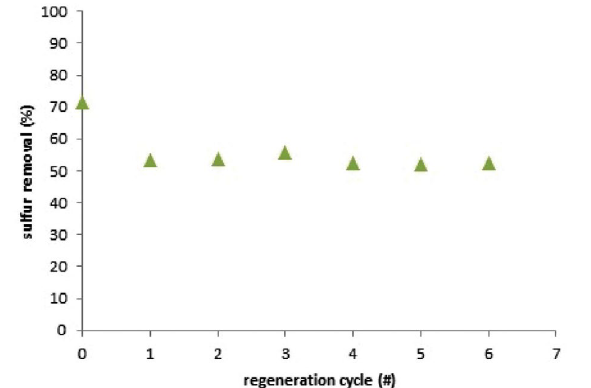
Fig. 11. Extent of sulfur removal as a function of number of regeneration cycles